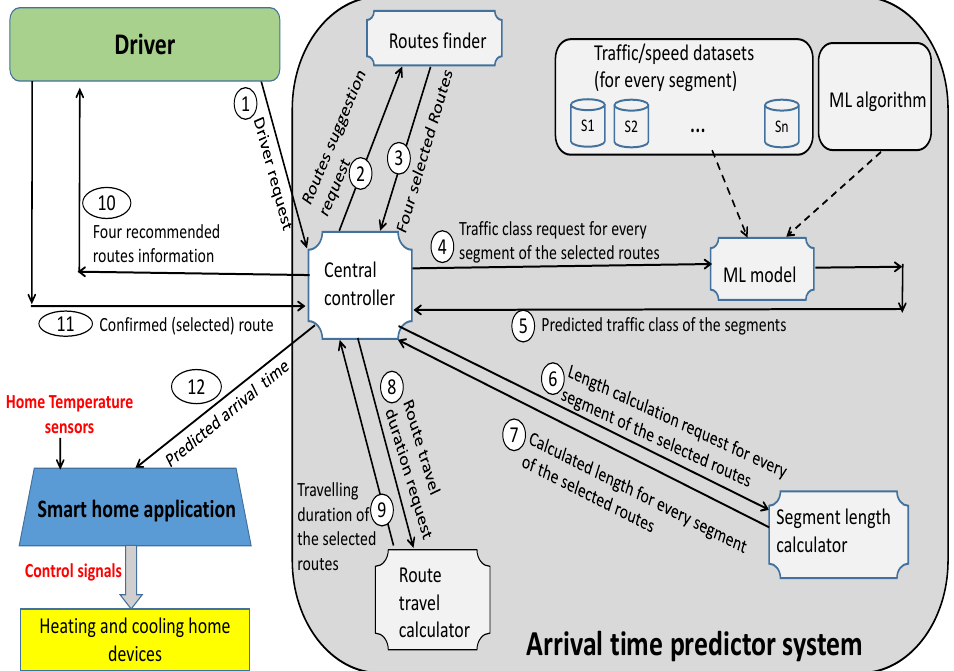
Figure 2. Working mechanism of the proposed